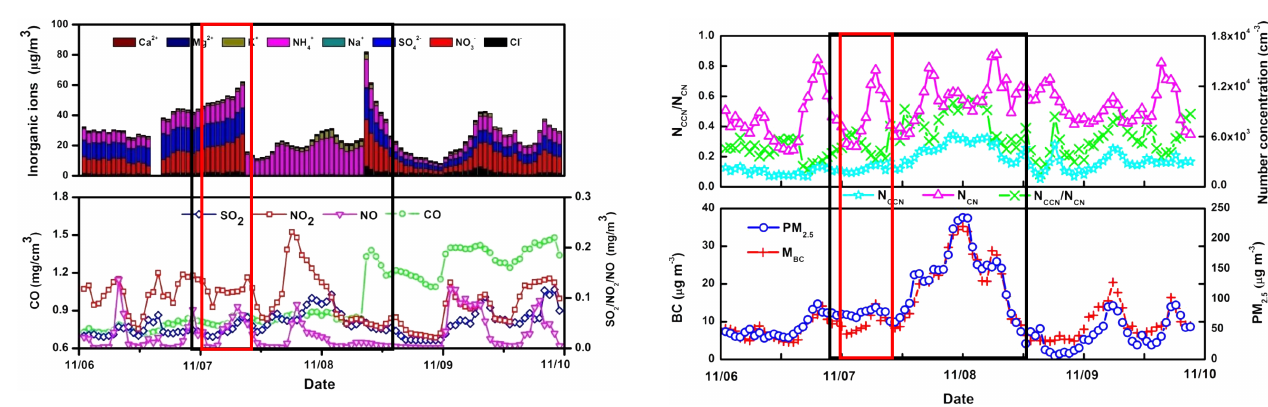
Figure 7. Temporal variations of N CN , N CCN at 0.2% SS, BC, PM 2 . 5 and N CCN /N CN , the foggy–hazy case is marked in red open boxes and hazy case in black